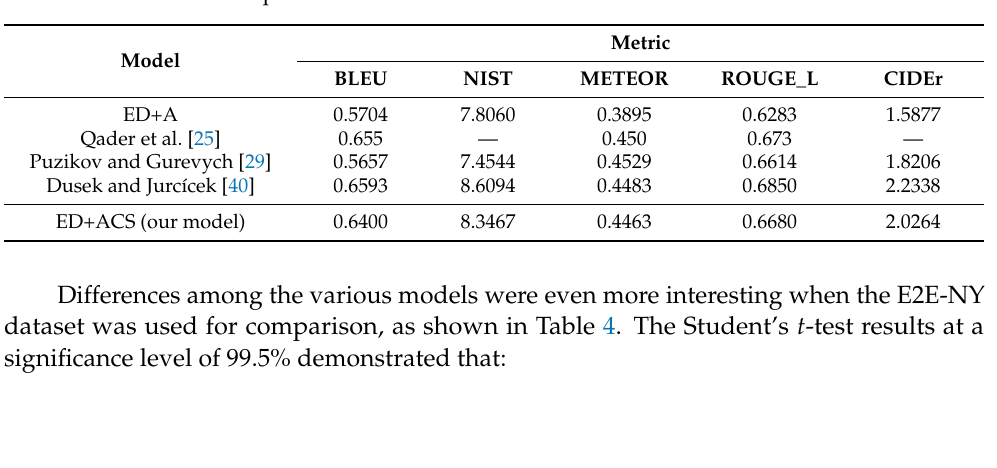
Table 3. Performance comparison on the E2E test